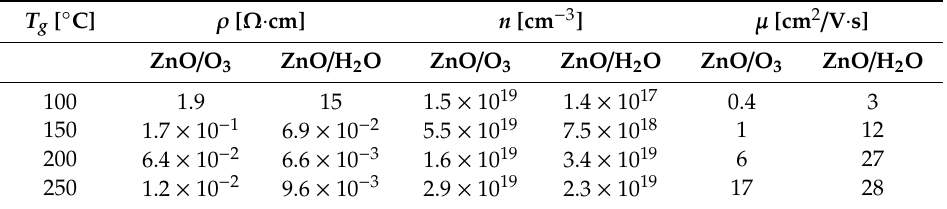
Table 2. Electrical parameters of investigated ZnO water-based and ZnO ozone-based samples: resistivity ( ρ ), carrier concentration ( n ), carrier mobility ( µ ).